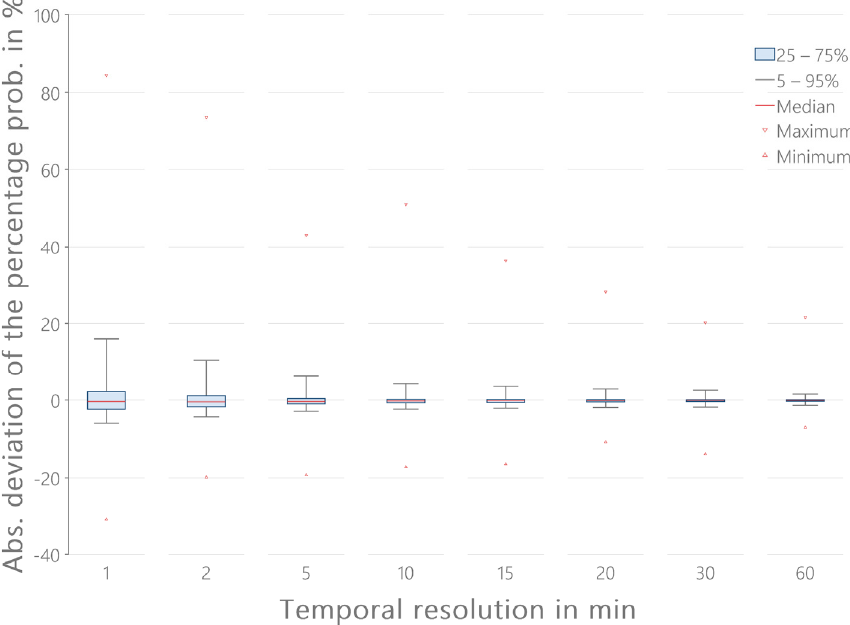
Figure 11. Absolute deviation of the percent probability from discrete and logarithmic normal distribution for different temporal resolutions.